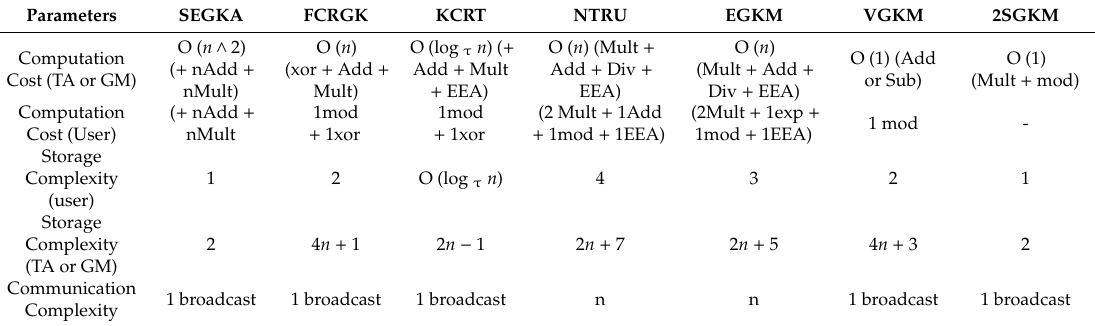
Table 6. Computation and communication cost of group key generation protocols.